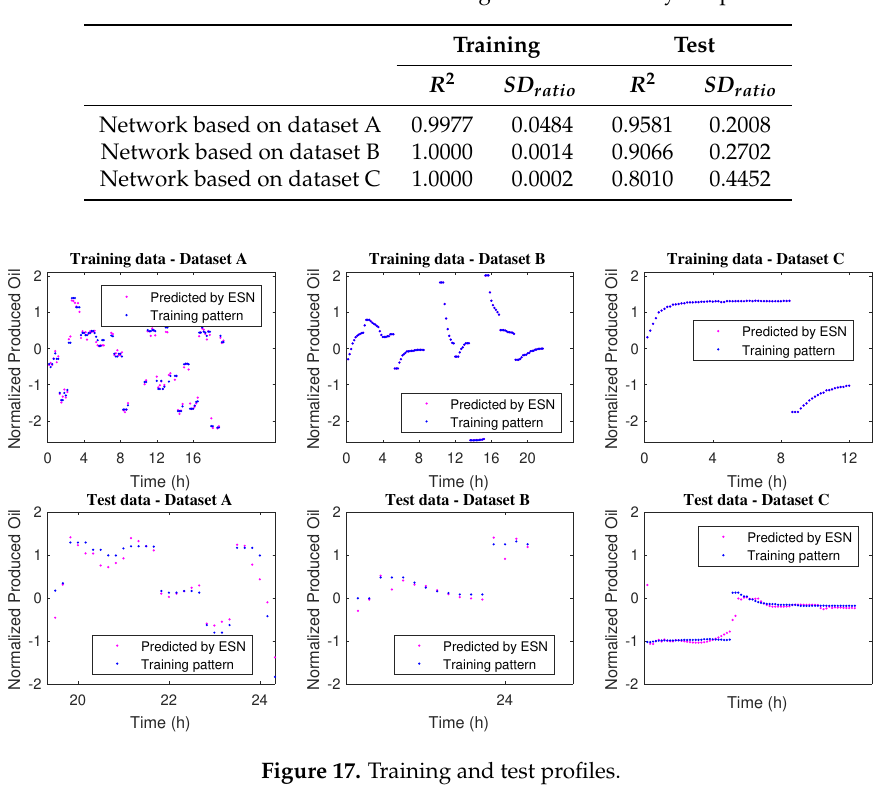
Figure 16. Raw data time serie profiles. Table 11. Performance Indices for training and test—one day of operation.